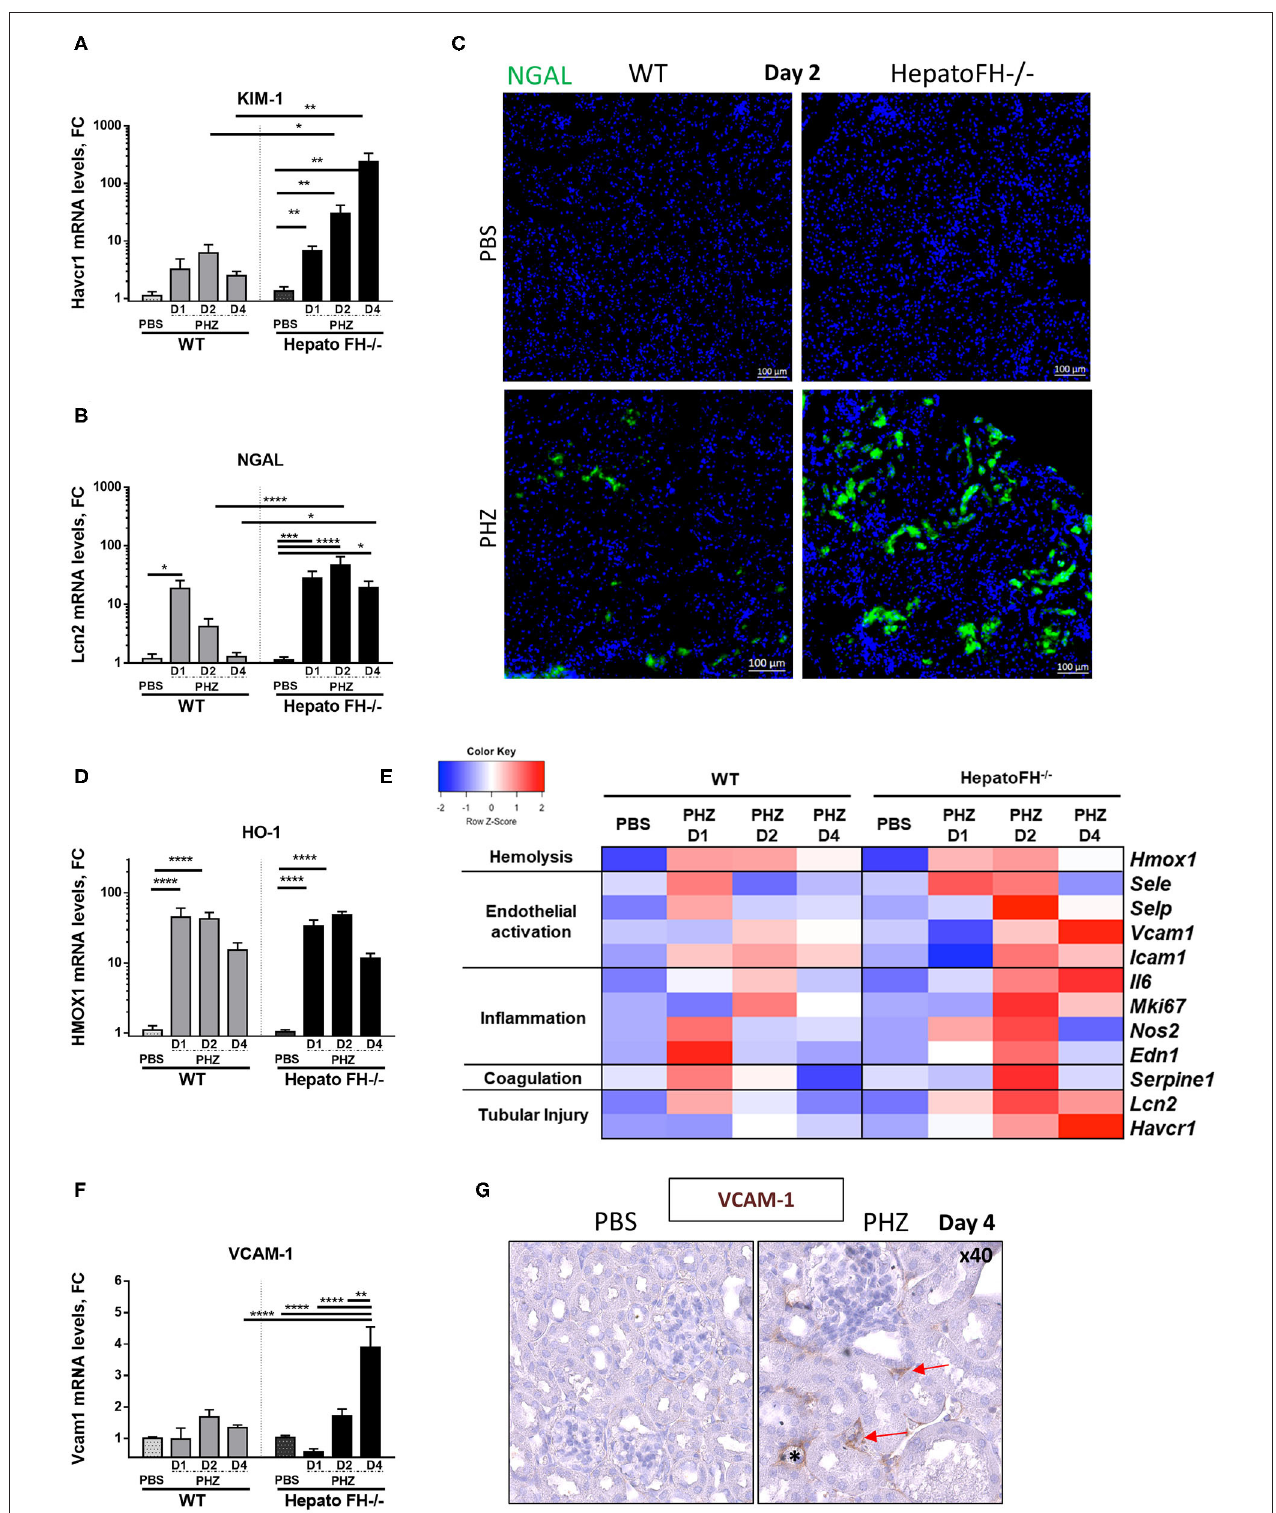
FIGURE 2 | Factor H deficiency increases tubular injury after hemolysis. (A,B) Assessment of acute tubular injury by mRNA renal expression of Kim1 ( Havcr1 ) (A) and NGAL ( Lcn2 ) (B) , after PBS or PHZ injection (day 1, 2, and 4) in WT and hepatoFH − / − mice. (C) Examples of NGAL staining (false green color) in tubular cells, by IF on frozen kidneys after PBS or PHZ injection in WT and HepatoFH − / − mice (5x). (D) Renal expression of Heme oxygenase 1 (HO-1, Hmox1 ) mRNA after PBS or PHZ injection (day 1, 2, and 4) in WT and hepatoFH − / − mice. (E) Heatmap summarizing the impact of hemolysis in renal mRNA expression: assessment